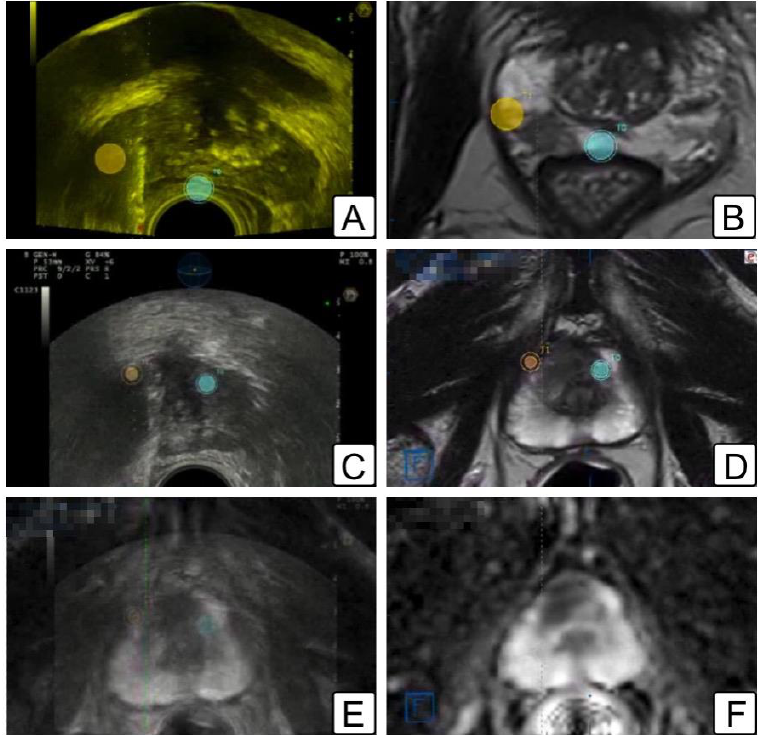
Figure 2. Illustrations of MRI/TRUS fusion biopsy. ( A , B ) Peripheral zone target biopsy: ( A ) trans-rectal ultrasound showing the location of the two lesions (orange and blue dots); ( B ) same lesions depicted in a T2-w MR (orange and blue dots). ( C – F ) anterior zone target biopsy: ( C ) trans-rectal ultrasound showing the location of the two lesions (orange and blue dots); ( D ) same lesions depicted in a T2-w MR (orange and blue dots); ( E ) fusion image overlapping T2-w MR image on top of transrectal ultrasound (lesions represented as orange and blue dots); ( F ) ADC map of the corresponding lesions.